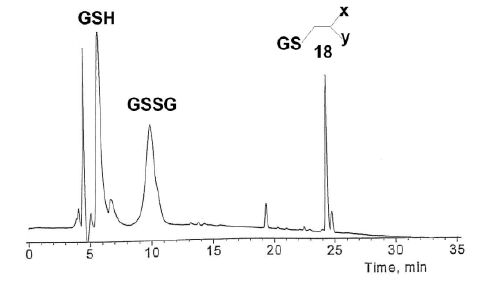
Figure 3. RP-HPLC profile for the glutathione conjugate of 2-cyano- N - phenethylacrylamide observed during the HLE-catalyzed hydrolysis of thymidine 5´-bis[3- acetyloxy-2-cyano-2-(2-phenylethylcarbamoyl)propyl]phosphate( 1 ) in the presence of GSH at pH 6.2 and 37.0 °C. Chromatographic conditions: A mixture of water and MeCN containing 0.1% formic acid (linear gradient from 1% up to 50.0% MeCN in 35 min). HPLC-signals were recorded on a UV detector at a wavelength of 215 nm.